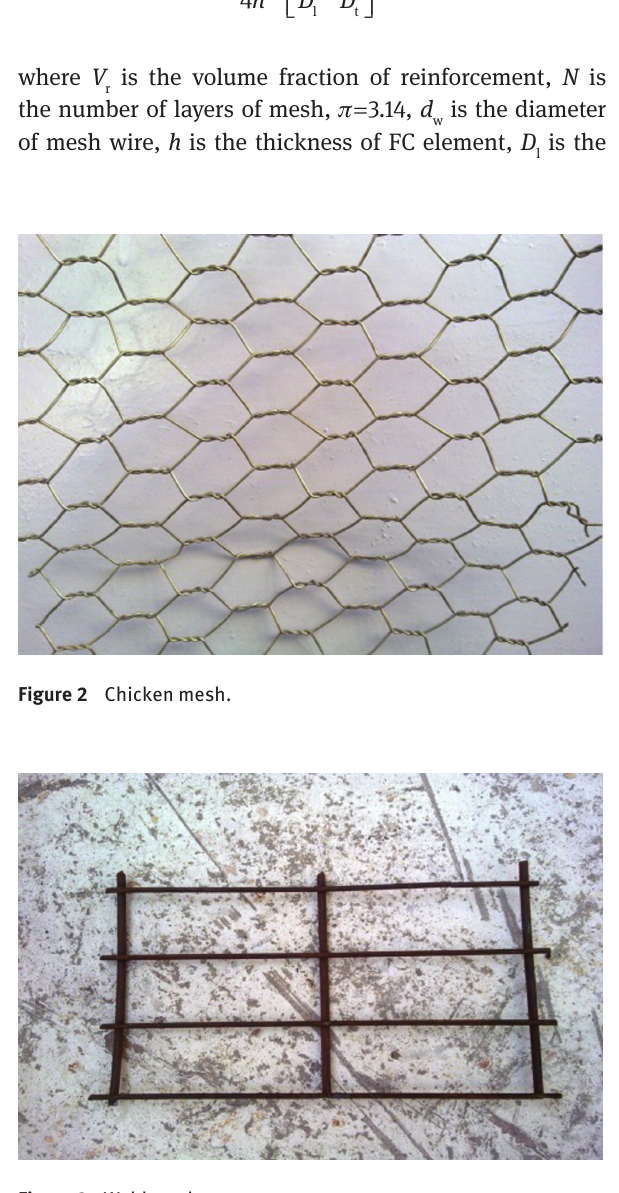
Figure 1 Composition of geopolymer mortar. Figure 3 Weld mesh.